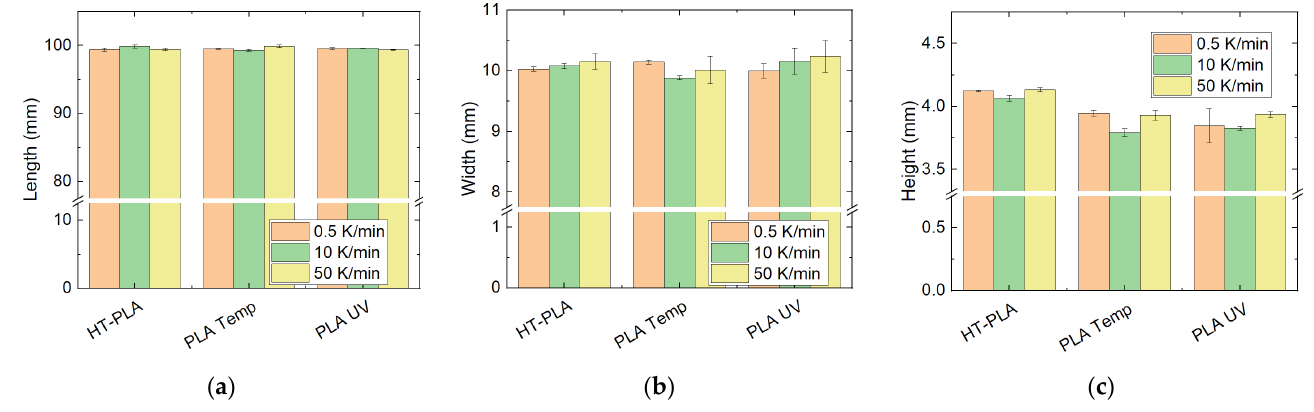
Figure 12. Dimensions of chosen PLA materials, heat-treated at 100 °C, approached with different heating rates: ( a ) length; ( b ) width; ( c ) height.